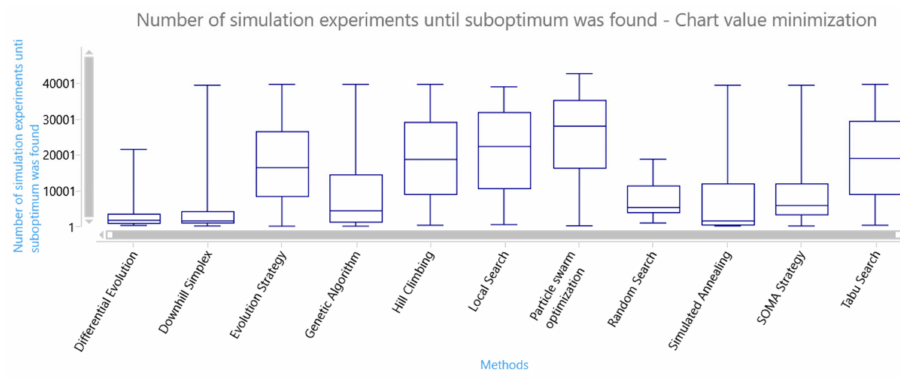
Figure 16. Box plot of the speed in finding a suboptimum of the objective function.